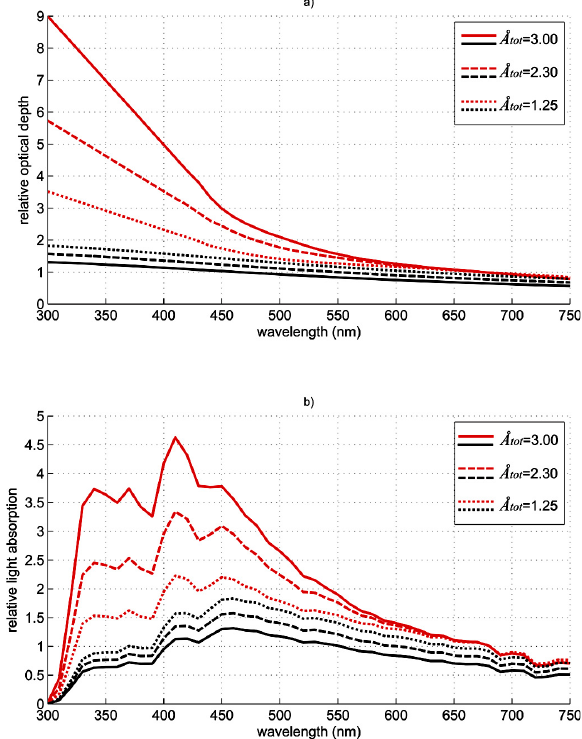
Fig. 1. Relative optical depth for absorption (top), weighted by the downwelling solar radiation (bottom) for all light-absorbing aerosol (red) and for BC only (black) for three sample filters cov- ering a range of values of ˚A tot measured in our survey. The ratio of the area between the black curve and the red curve to the area under the red curve (bottom panel) gives f est , which for the nonBC three cases shown is 64% ( ˚A tot =3.00; Canadian Arctic sample), 45% ( ˚A tot =2.30; sample near the North Pole) and 18% ( ˚A tot =1.25; Svalbard